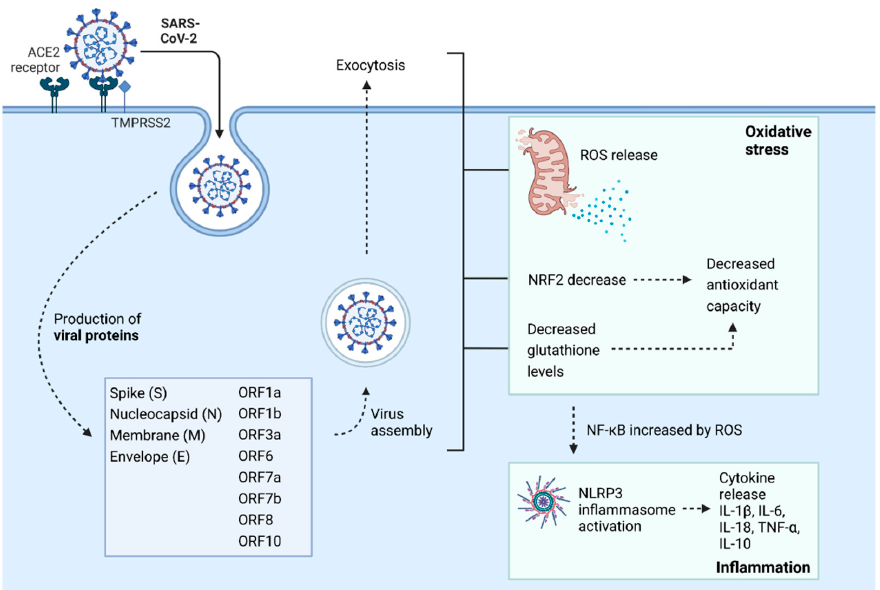
Figure 1. COVID-19 and oxidative stress. Abbreviations: ACE2: Angiotensin-Converting Enzyme 2, SARS-CoV2: severe acute respiratory syndrome coronavirus 2, TMPRSS2: Transmembrane prote-